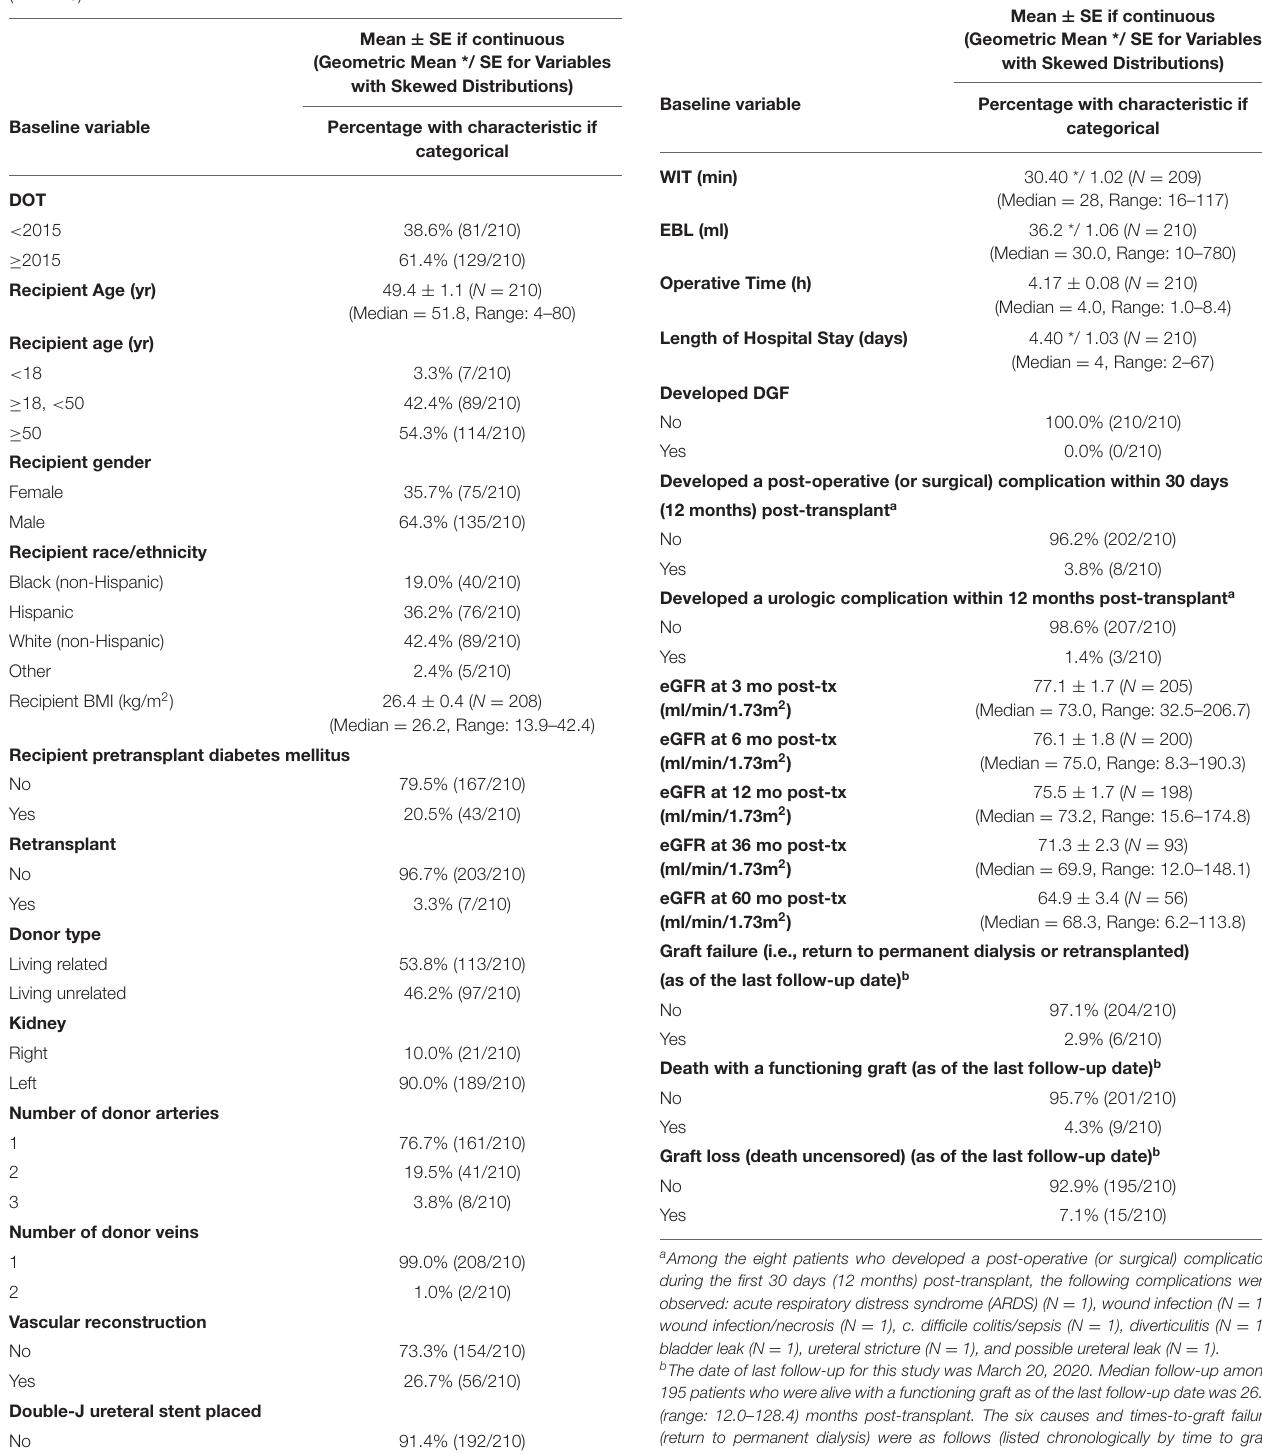
TABLE 1A | Distributions of selected baseline variables and outcome variables ( N = 210).